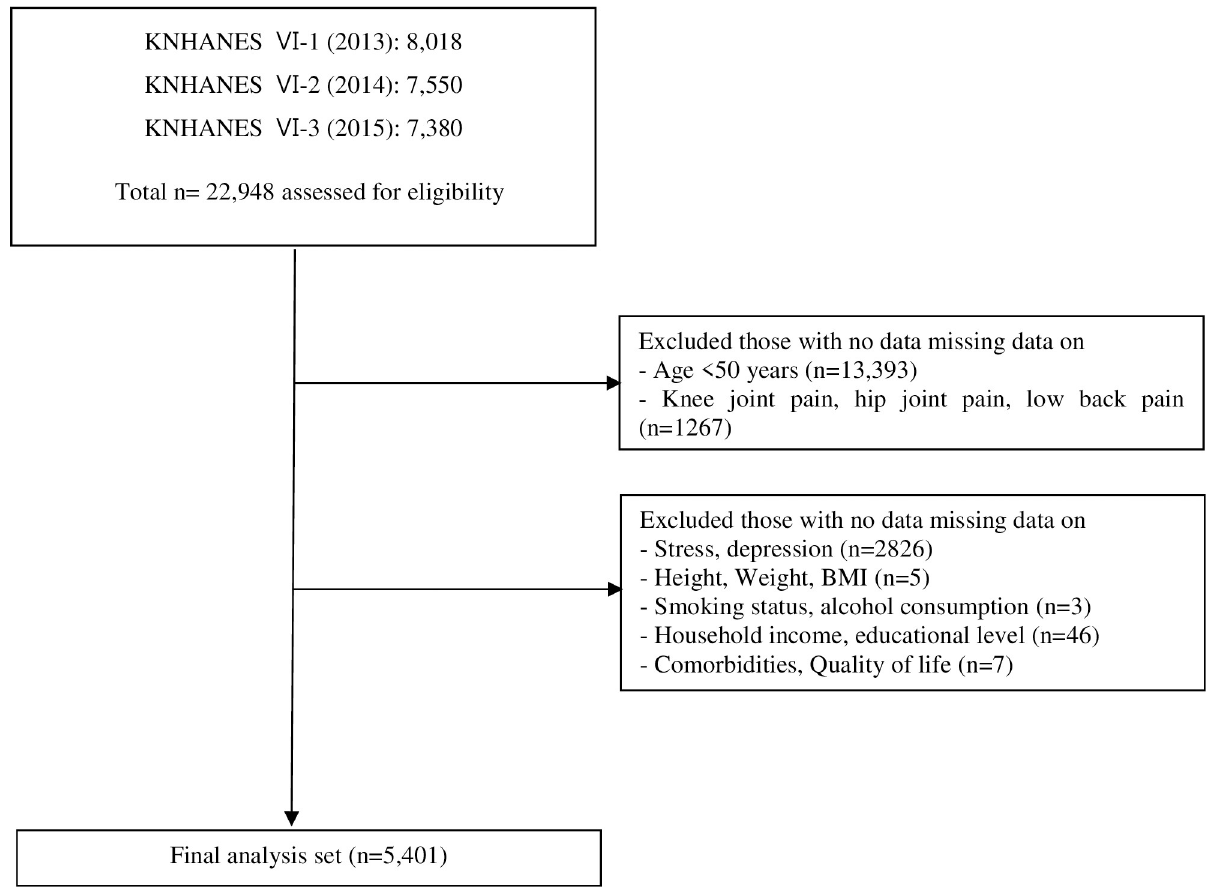
Fig 1. Subjects excluded from the analysis. KNHANES = Korean National Health and Nutrition Examination Survey; Comorbidities = angina, diabetes mellitus, hypertension, myocardial infarction, rheumatoid arthritis, and stroke.